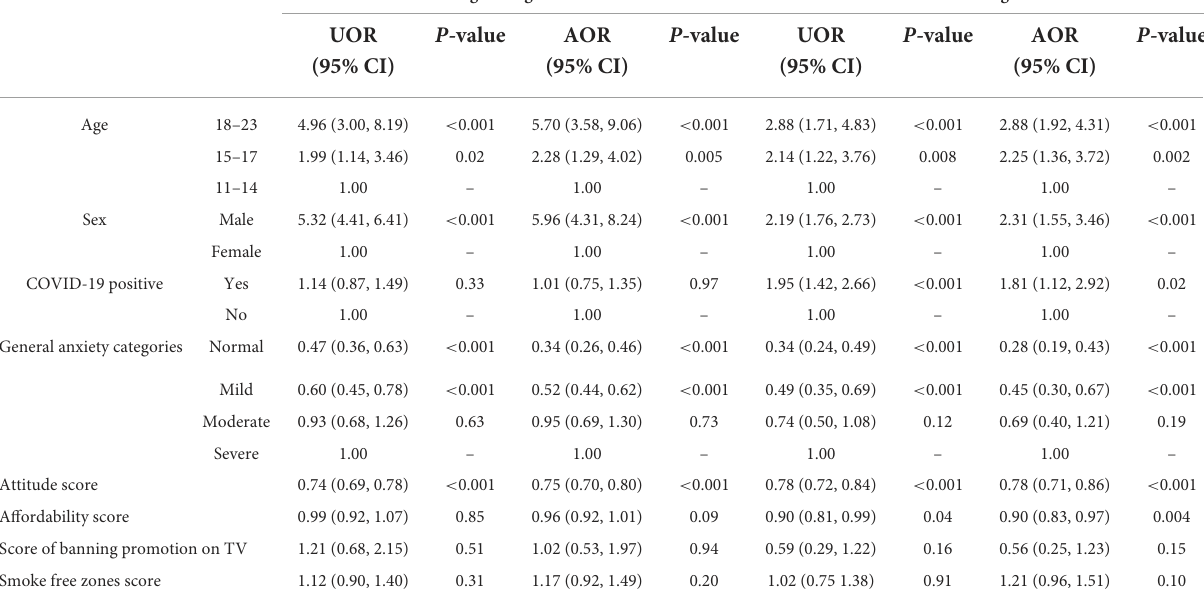
TABLE 3 Factors associated with using cigarettes and electronic cigarettes in AYA in 25 countries ( N = 6,989).